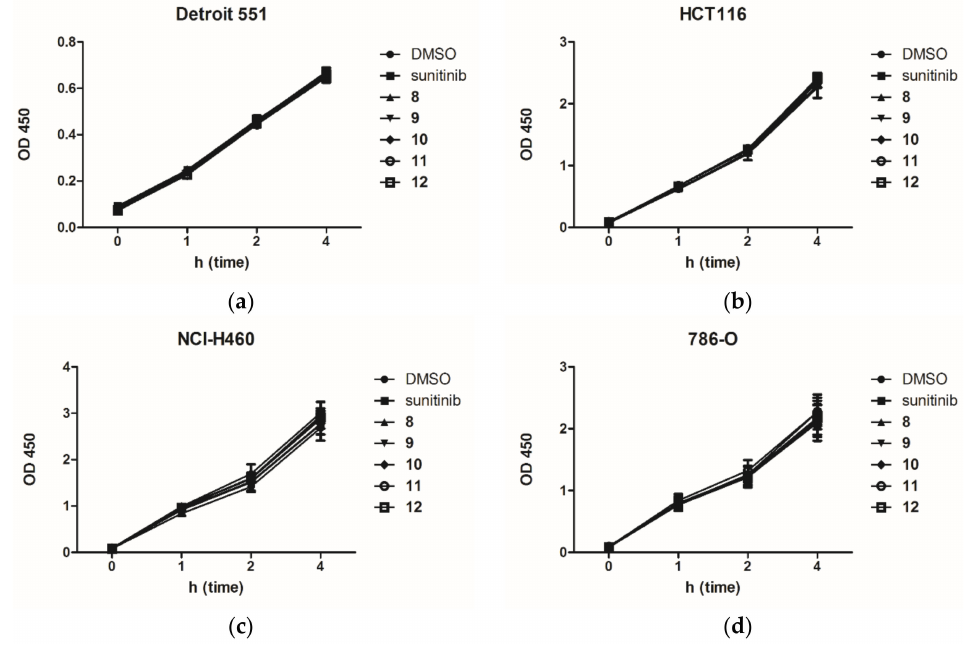
Figure 3. Acute cytotoxicity assay of ( a ) Detroit 551; ( b ) HCT116; ( c ) NCI-H460; ( d ) 786-O cells incubated with DMSO (1%), sunitinib and 8 – 12 (10 µ